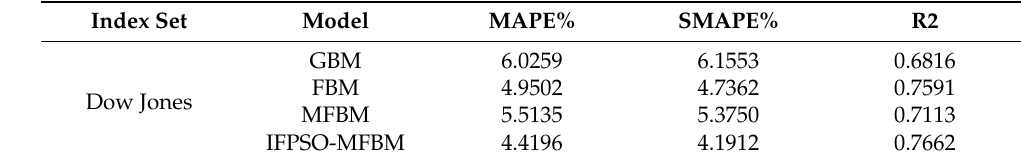
Table 12. Comparative error analysis of Dow Jones index under four